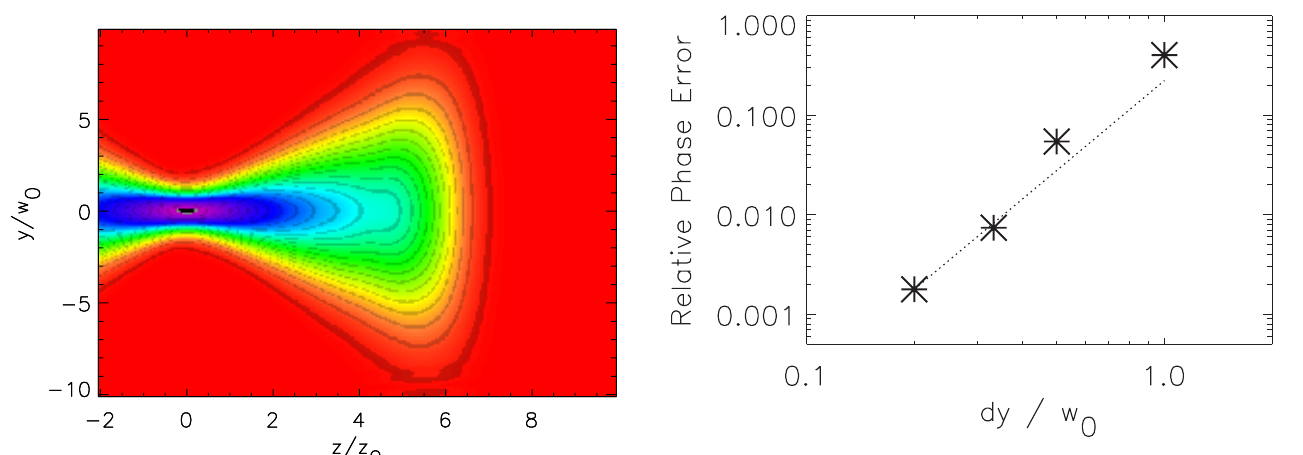
FIG. 4. Phase error of the Gouy phase shift, as a function of transverse resolution. The error follows a (cid:1) y 3 dependency (dotted